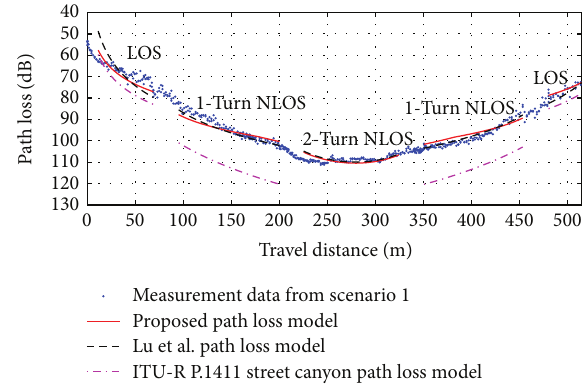
Figure 9: Comparison of the proposed path loss model (fitting to the measurement data), Lu et al. model in [6], and the ITU-R Street Canyon model [17] for Scenario 2 in Figure